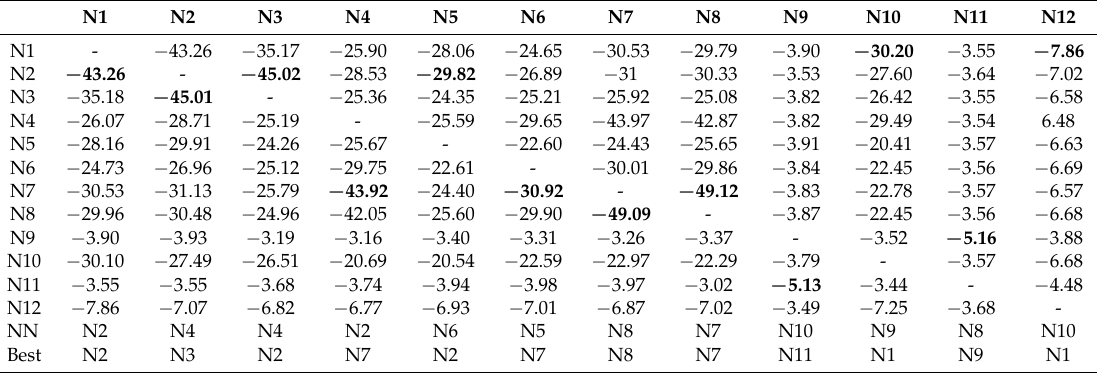
Table 2. ADF-test for time series, Best Match bold , NN = Physically Nearest